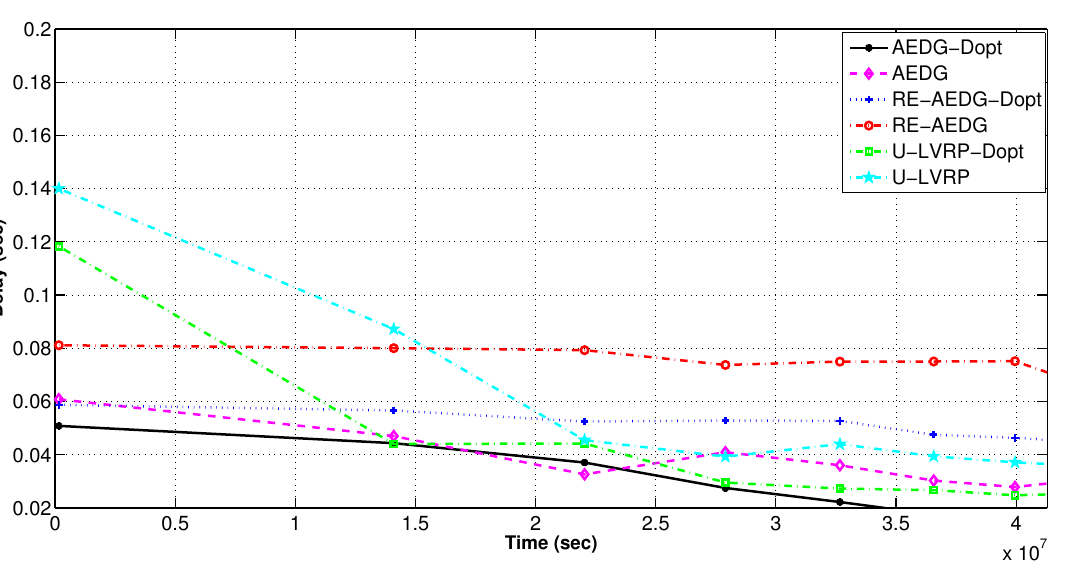
Figure 9. Message latency in delay optimized and non optimized